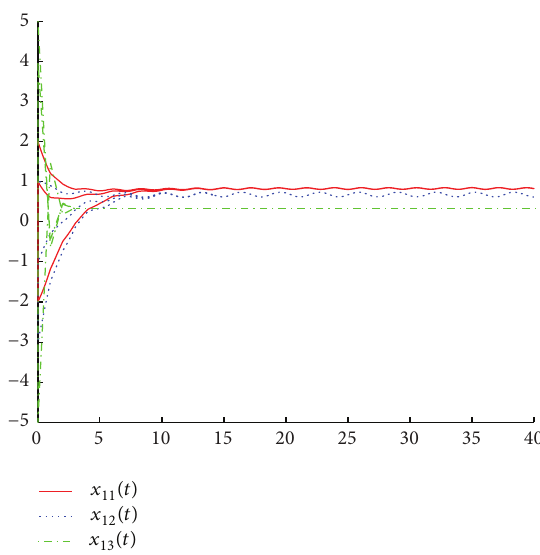
Figure 1: Numerical solutions of system (76) for different initial values.